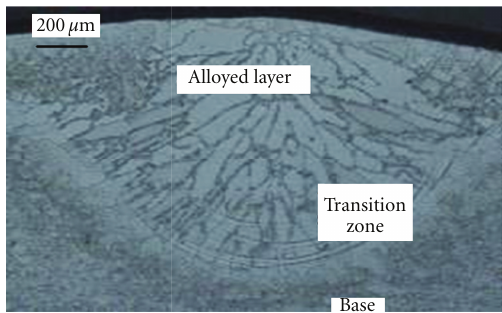
Figure 1: Typical cross section of the laser alloyed